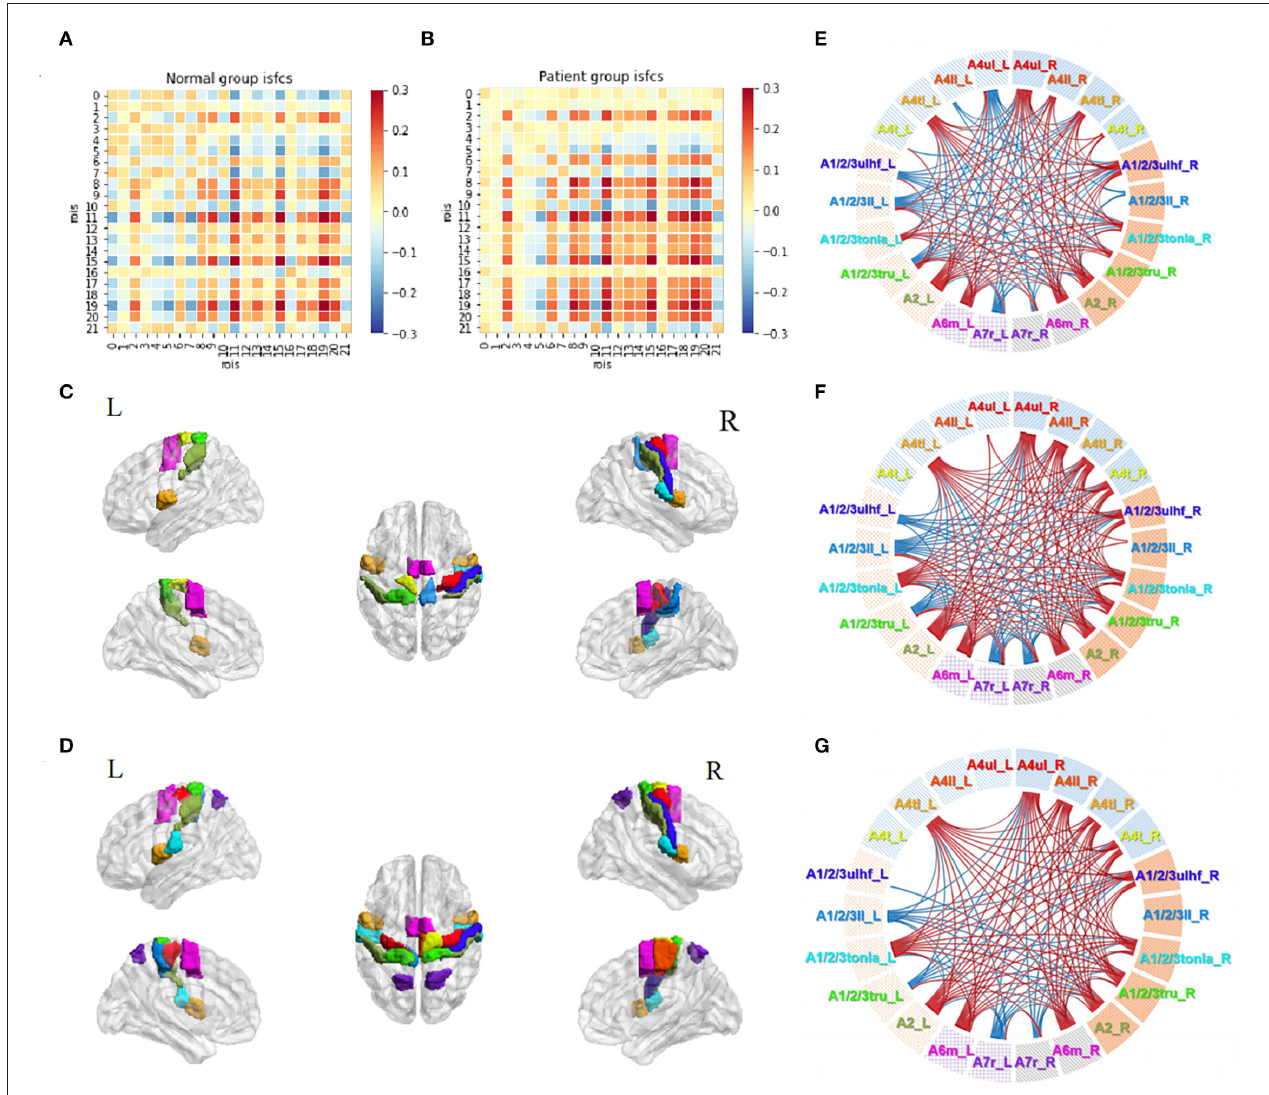
FIGURE 5 | Motor task-stimulated ISC and ISFC. (A) ISFC matrix of 22 ROIs during motor task in the control group. (B) ISFC matrix of 22 ROIs during motor task in the patient group. (C) Significantly stimulated ROIs in the control group ( p < 0.01, FDR-corrected). (D) Significantly stimulated ROIs in the patient group ( p < 0.01, FDR-corrected). (E) Significant positive (lines in red) and negative (lines in blue) ISFCs between ROIs in the control group ( p < 0.01, FDR-corrected). (F) Significant ISFCs between ROIs in the patient group ( p < 0.01, FDR-corrected). (G) Significant ISFCs between ROIs in the patient group ( p < 0.001, FDR-corrected).